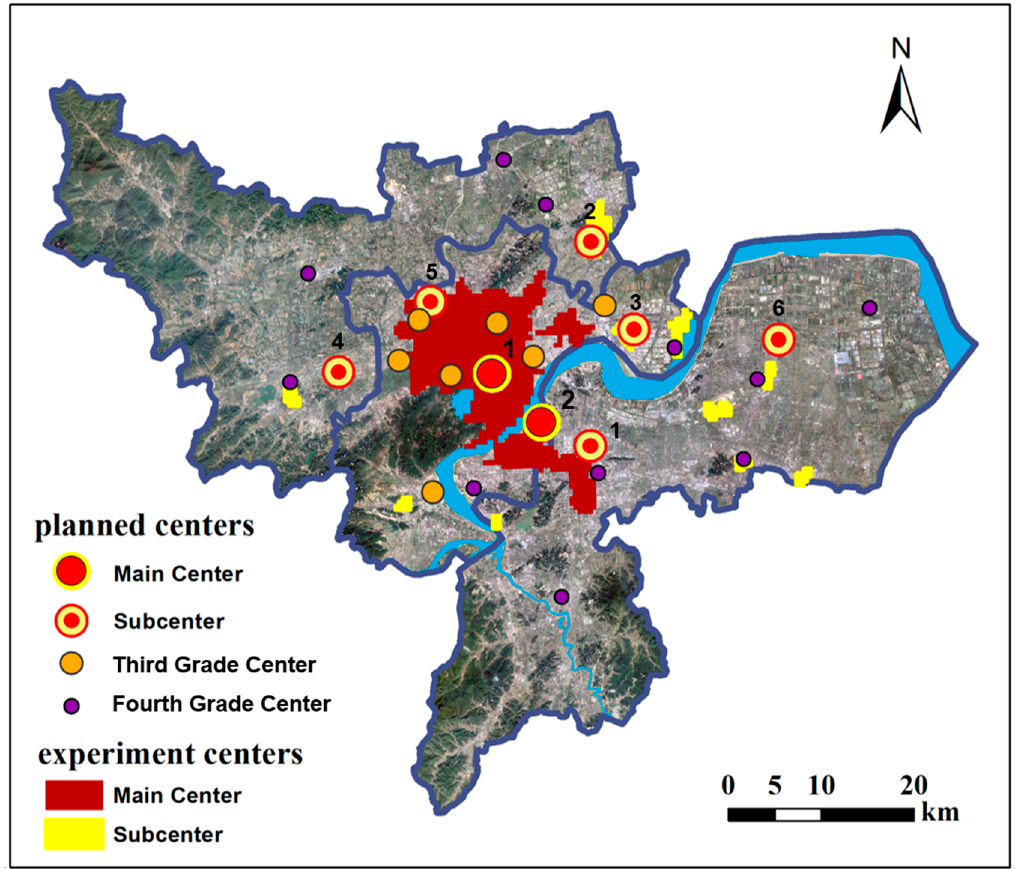
Figure 14. Centers proposed in the master plan and detected by our experiment. Table 2. Evaluation of the central system from the Report (excerpts).